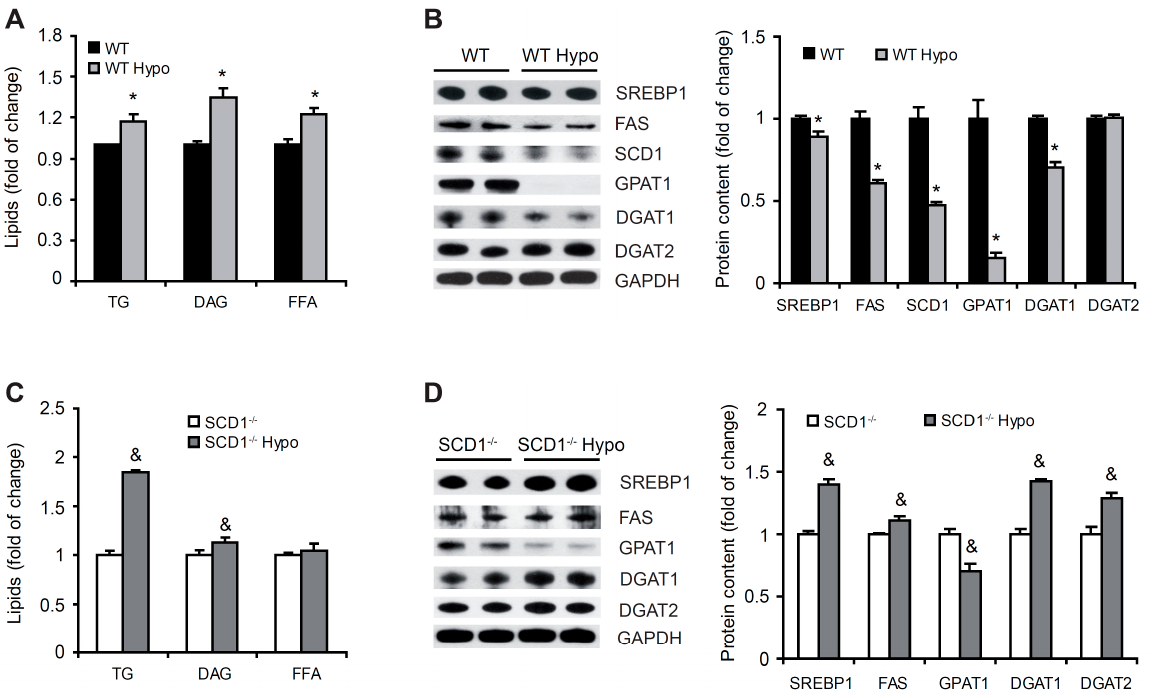
Figure 3. ( A , C ) Free fatty acid (FFA), diacylglycerol (DAG), and triglyceride (TG) content in the heart in wildtype (WT) and SCD1 -/- mice under physiological and hypothyroid conditions. Lipid extracts were separated by thin-layer chromatography. The plate was soaked in a water mixture that contained cupric sulfate and phosphoric acid and charred. Lipids were then quantified by densitometry. ( B , D ) Levels of lipogenic proteins in cardiomyocytes in WT and SCD1 -/- mice under physiological and hypothyroid conditions. Protein levels of sterol regulatory element-binding protein 1 (SREBP-1), fatty acid synthase (FAS), stearoyl-CoA desaturase 1 (SCD1), glycerol-3-phosphate acyltransferase 1 (GPAT1), diacylglycerol acyltransferase 1 (DGAT1), and DGAT2 were determined by Western blot. The data are representative of n = 5 animals/group. The data are expressed as mean ± SD. * p < 0.05, vs. WT; & p < 0.05, vs. SCD1 -/- .